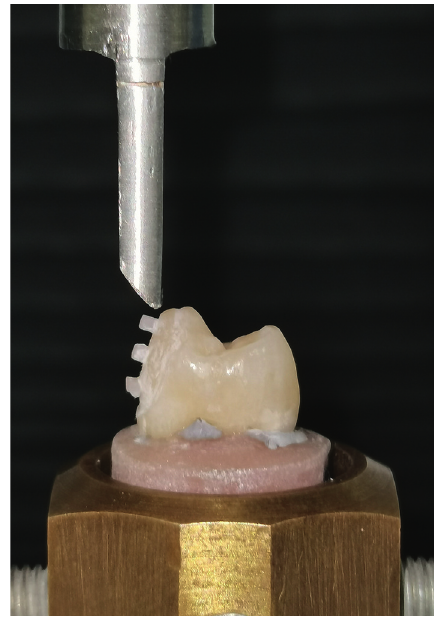
Figure 3: Microshear bond strength test using universal testing machine.